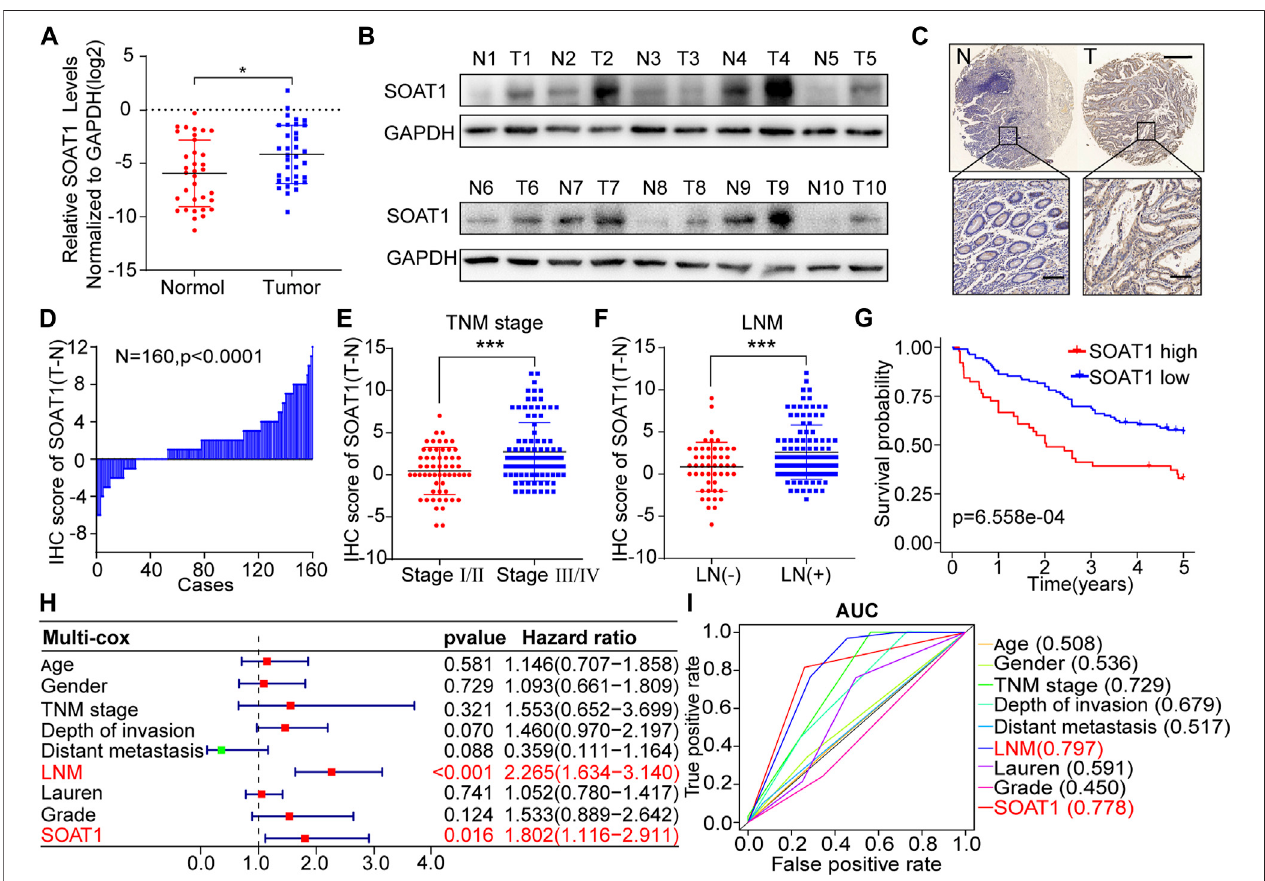
FIGURE 2 | SOAT1 expression is elevated in GC and correlates with poor prognosis in GC patients. (A) The relative RNA expression level of SOAT1 in GC and corresponding noncancerous tissues was measured by qRT-PCR ( n (cid:1) 34). (B) The protein level of SOAT1 was measured by western blot assay in GC tissues and the corresponding noncancerous tissues ( n (cid:1) 10). (C) Representative IHC images of the TMA probed with the anti-SOAT1 antibody (scale bars (cid:1) 200 and 50 μ m, respectively)wereshown. (D) Thedistributionofthedifferencesintheimmunoreactivityscore(IRS)forSOAT1stainingwasavailablefor160pairsofGCtissuesand thecorrespondingnoncanceroustissues( Δ IRS (cid:1) IRST-IRSN). (E,F) CorrelationofSOAT1expressionwithTNMstage (E) andLNM (F) inGCtissuesbasedonTMAdata. (G) Kaplan-Meier OS analysis of GC patients strati fi ed by the relative SOAT1 expression level. (H) Multivariate analyses were performed with the above-mentioned GC patients, and all bars correspond to 95% con fi dence intervals (CIs) and hazard ratios (HRs). (I) Receiver operating characteristic (ROC) analysis of the risk factors in the above-mentioned GC patients.